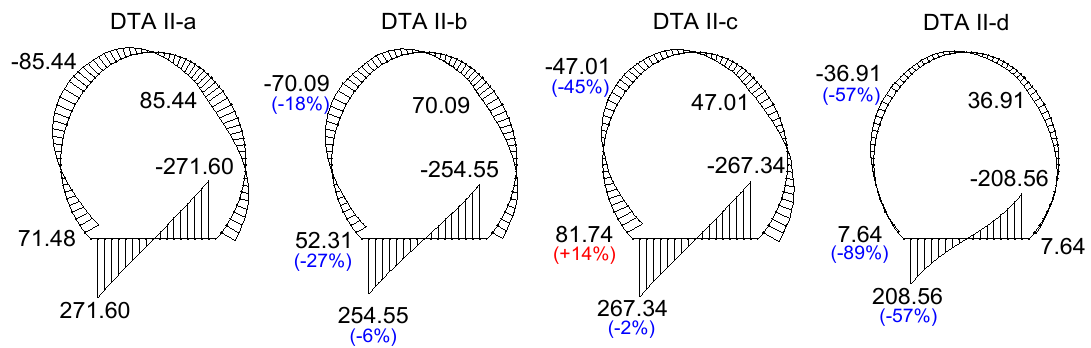
Figure 15. Comparison of the shear force (kN) for DTA II culvert (H =